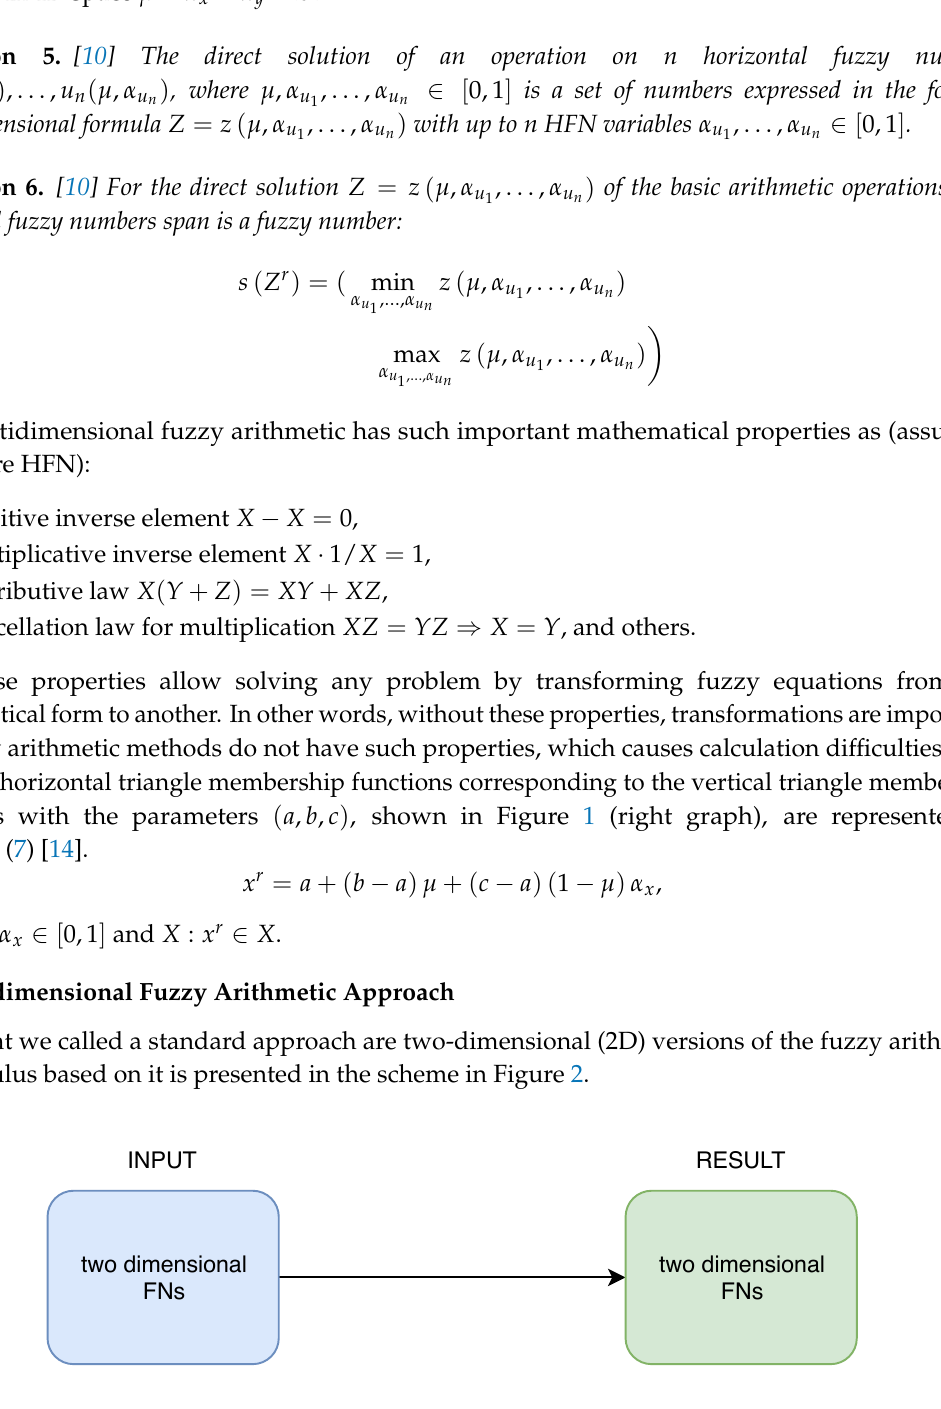
Figure 2. A standard approach (2D) scheme in fuzzy